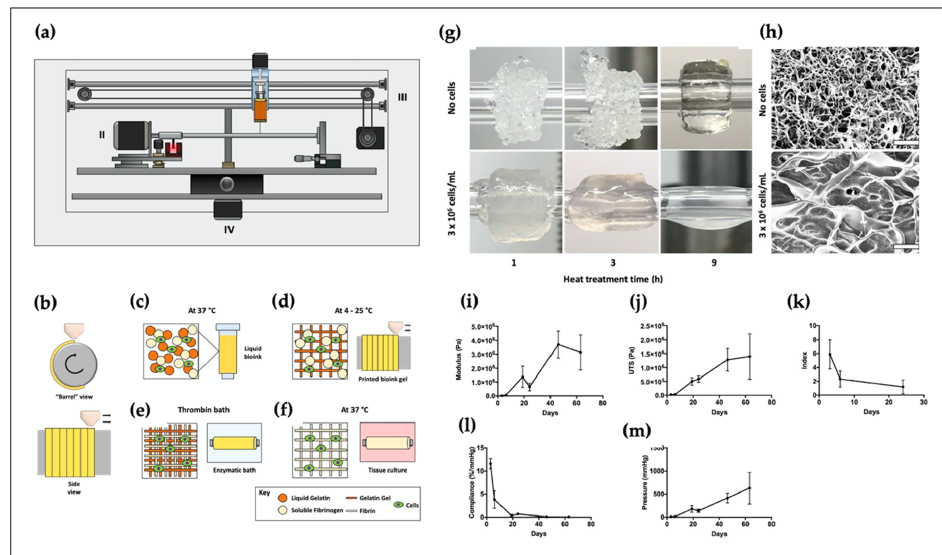
Figure 8. Development of a tubular structure using a rotary 3D bioprinting system. ( a ) A rotary 3D